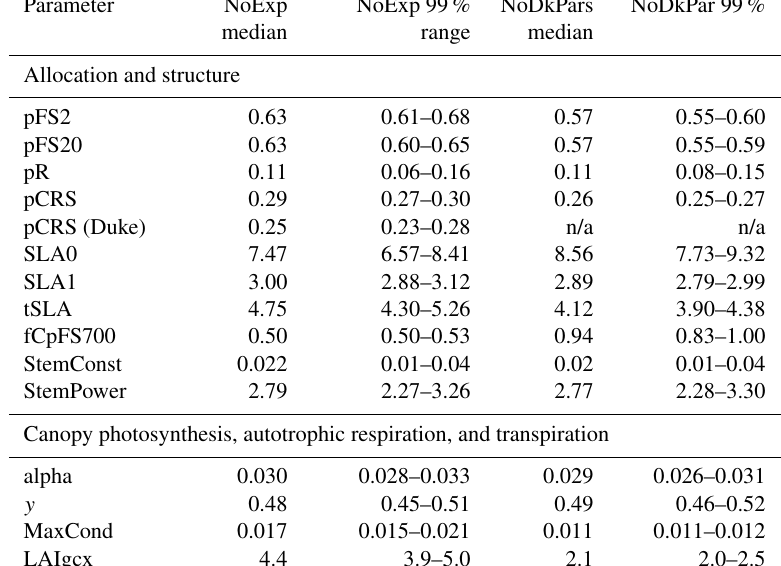
Table 6. Median and range of the 99% quantile intervals of the posterior distributions for the parameters in the NoExp and NoDkPars